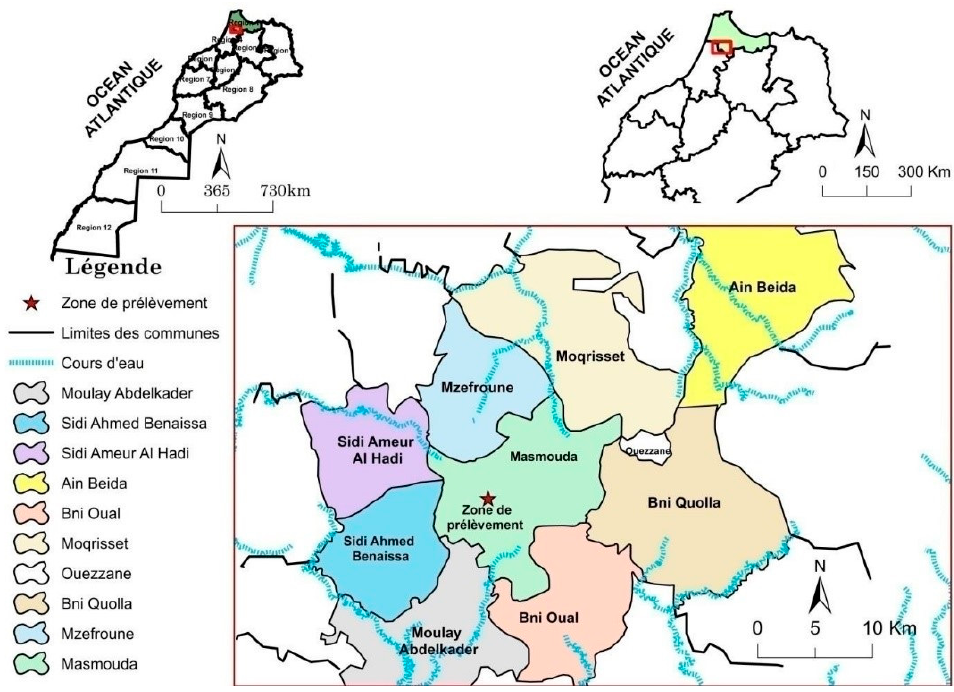
Figure 2. Geographic map of the sampling area.